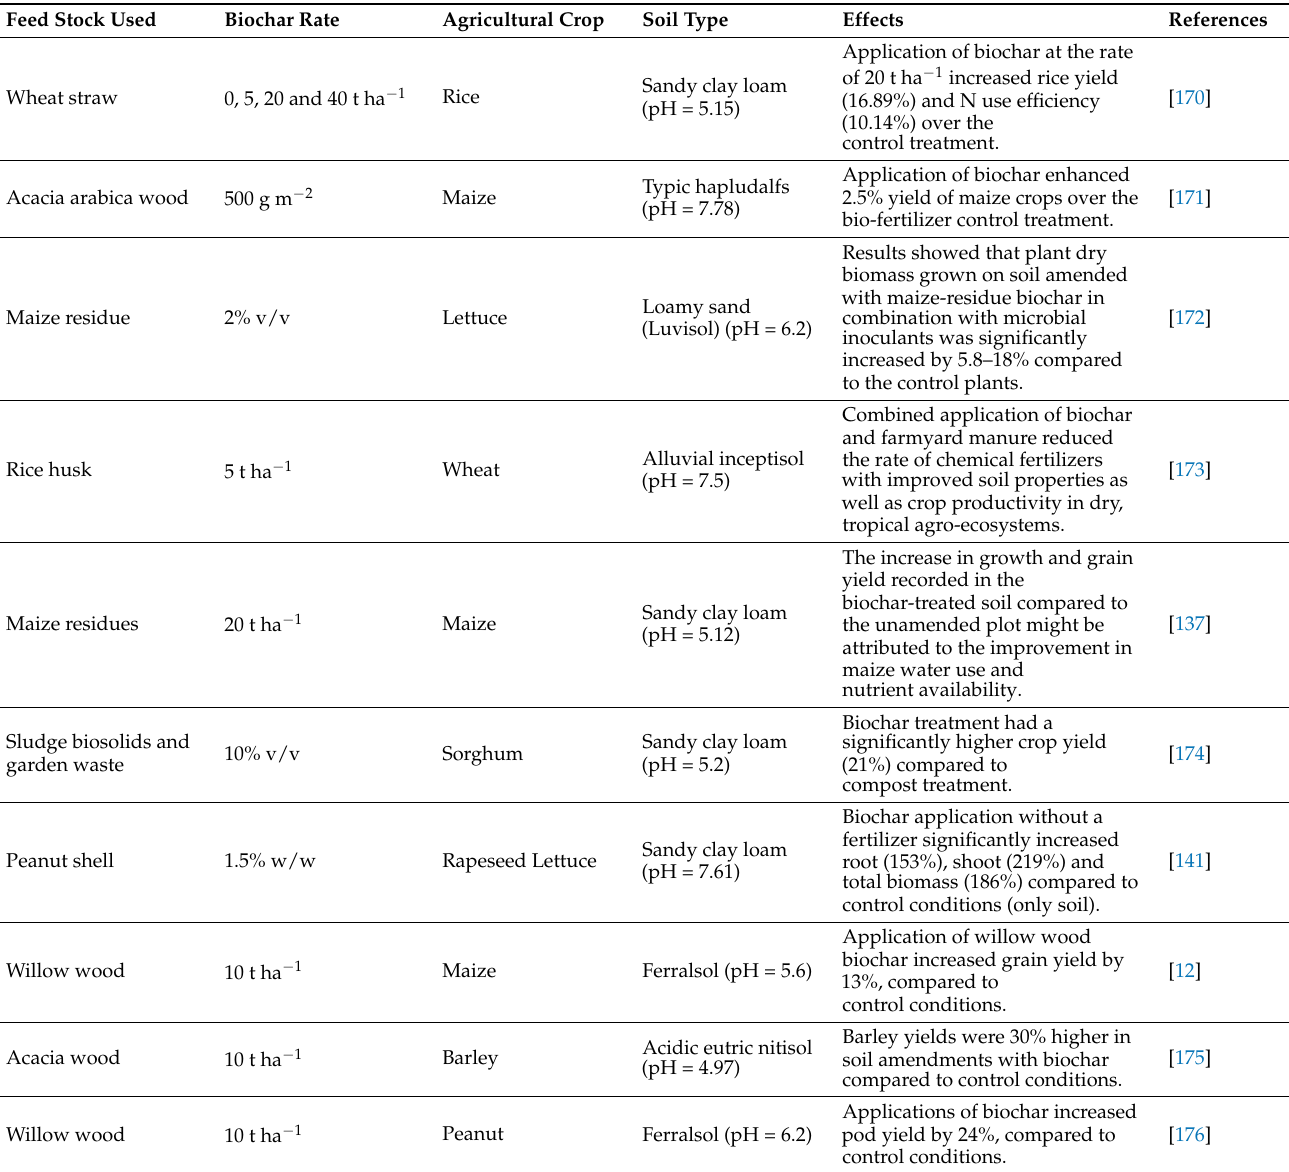
Table 3. Effects of biochar on crop growth and